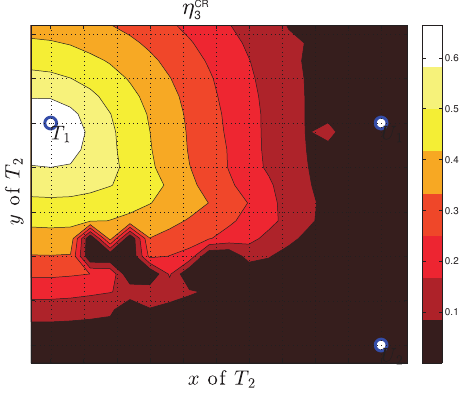
Figure 2: Distribution of η 3 depending on the loca- tion of T 2